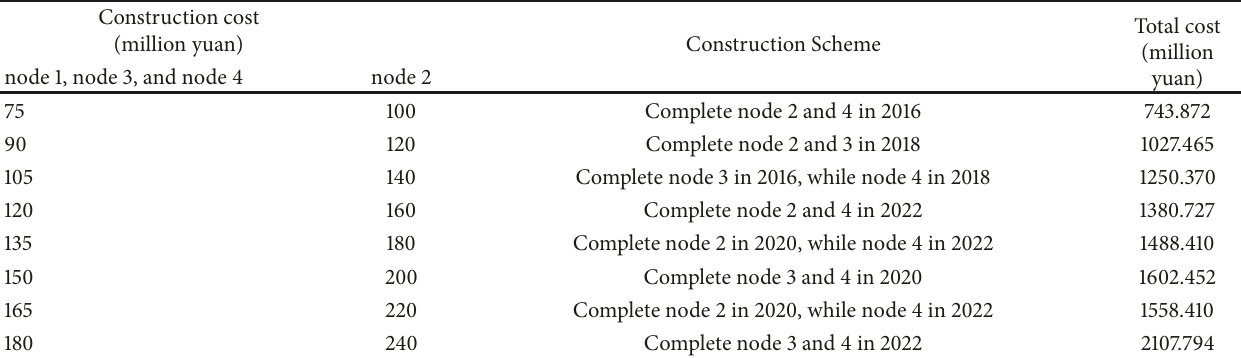
Table 6: Sensitivity analysis of the construction cost of